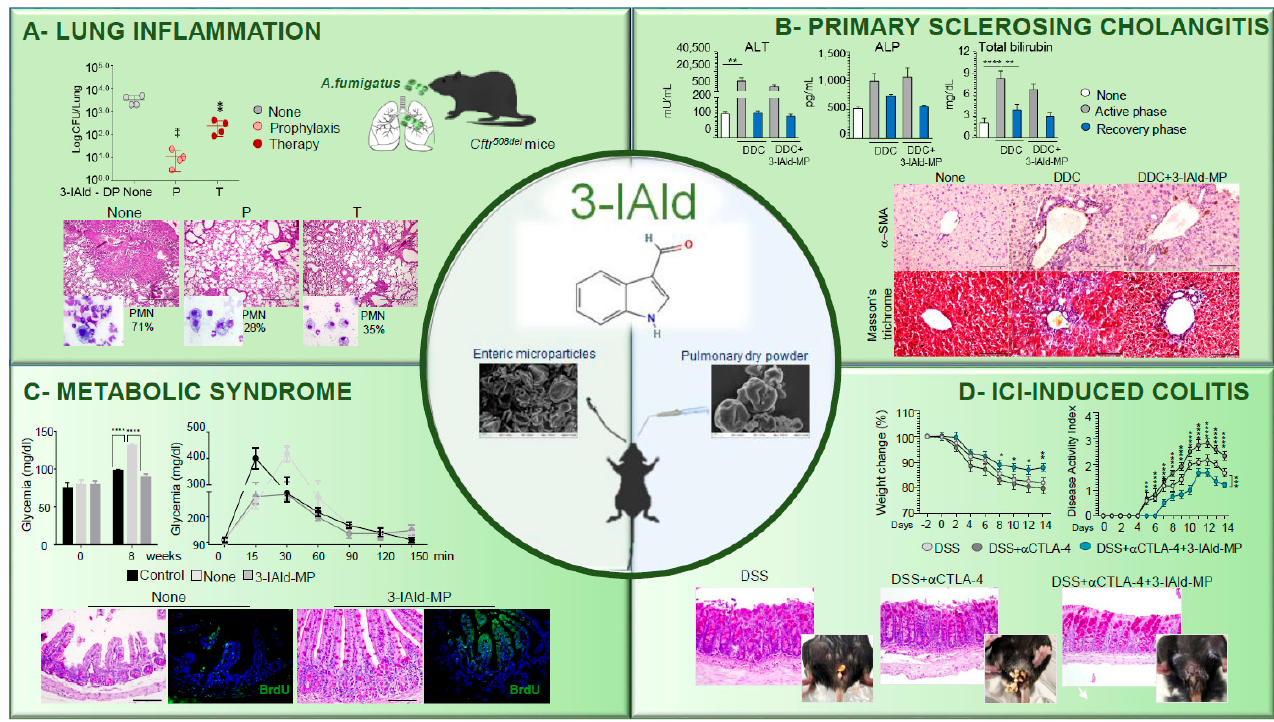
Figure 1. Therapeutic activity of 3-IAld in experimental models of human inflammatory diseases. ( A ) Pulmonary insufflation of 3-IAld dry powder (DP) either before (P, prophylaxis) or after (T, therapy) prevents lung inflammatory pathology in Cftr F508del/F508del mice infected with Aspergillus fumigatus conidia, as revealed by the fungal growth, lung histopathology, and neutrophil recruitment ([48]). Photographs were taken using a high-resolution Olympus DP71 microscope using a 10× objective. Scale bar 400 µm. Values represent the mean ± SD of four mice per group or are representative of three experiments. Naïve, uninfected mice; None, infected mice. ** p < 0.01, one-way ANOVA—Bonferroni’s, P or T vs. None. ( B ) 3-IAld microparticles (MP) reduces liver injury and fibrosis in C57BL/6 mice fed with a DDC-containing diet (active phase) and subjected to a recovery time (recovery phase) as revealed by serum levels of alanine aminotransferase (ALT), alkaline phosphatase (ALP), total bilirubin, fibroblast activation, and collagen deposition ([38]). Photographs were taken with a high-resolution microscope (Olympus BX51), 40× magnification (scale bars, 100 µm). ** p < 0.01, **** p < 0.0001, DDC-treated vs untreated (none) mice, and DDC vs. DDC + 3-IAld-MP. One-way ANOVA, Bonferroni post-test. ( C ) Oral administration of 3-IAld-MP decreases glycemia, promotes glucose tolerance, restores tissue architecture in the ileum, and promotes epithelial cell renewal (BrdU) in C57BL/6 mice on a high-fed diet. Control; control mice. None; high-fed diet-mice with MP alone ([35]). Photographs were taken with a high-resolution microscope (Olympus BX51), 20 × magnification (scale bars, 200 µ m). **** p < 0.001, 3-IAld-MP-treated vs MP-treated mice and None vs Control. ( D ) 3-IAld-MP protects mice from immune check-point inhibitor (ICI)-induced colitis. C57BL/6 mice were treated with DSS and anti-CTLA-4 mAb with and without 3-IAld and assessed for weight change, disease activity index, colon histopathology, and gross pathology (insets) ([41]). Photographs were taken with a high-resolution microscope (Olympus BX51), × 20 magnification (scale bars, 200 µ m). wo-way analysis of variance, Bonferroni post hoc test. * p < 0.05, ** p < 0.01, *** p < 0.001, **** p < 0.0001. anti-CTLA-4 + 3-IAld- versus anti-CTLA-4-treated